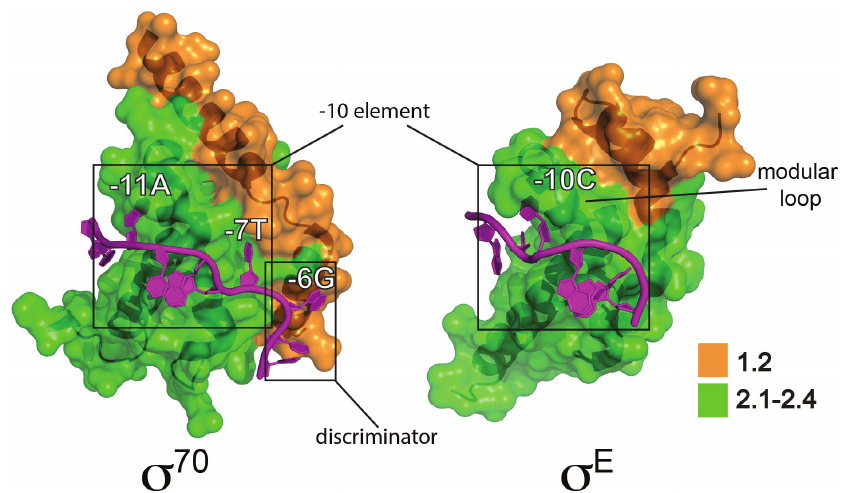
Figure 2. Interactions of E. coli (cid:2) 70 and (cid:2) E with “flipped out” bases in non-template strand of (cid:6)10 regions. The (cid:2) 70 -DNA model is a partial representation of a crystal structure of an E. coli (cid:2) 70 transcription initiation complex (PDB: 4YLN) [22] showing the (cid:2) 70 2 domain interactions with the non-template strand (C -13 T -12 A -11 T -10 A -9 A -8 T -7 G -6 T -5 G -4 ) Flipped out bases in the (cid:6)10 element ((cid:6)11A and (cid:6)7T) and the discriminator element ((cid:6)6G) are indicated. Note that DNA upstream of (cid:6)11A is double stranded, with the template strand not shown for clarity. The (cid:2) E -DNA model is based on a crystal structure of the E. coli (cid:2) E 2 domain bound to a non-template strand oligonucleotide (PDB: 4LUP) [23] based on the (cid:2) E consensus (cid:6)10 sequence (T -13 G -12 T -11 C -10 A -9 A -8 A -7 ). The modular loop that interacts with the flipped out (cid:6)10C is indicated. (cid:2) 2 domains are illustrated in surface representation with conserved regions colored as indicated and the (cid:2) 70 NCR not